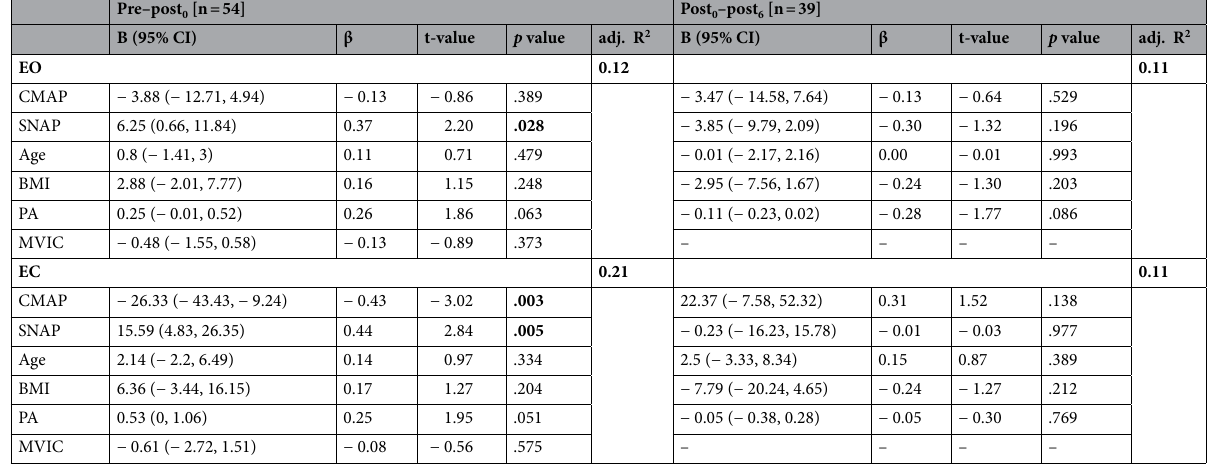
Table 3. Multiple linear regression analysis for predicting changes in postural control during and after neurotoxic chemotherapy. Results of multiple linear regression analysis investigating the influence of various predictors on changes in postural control during (pre–post 0 ) and after (post 0 –post 6 ) neurotoxic chemotherapy are shown. Bold p values are considered statistically significant ( p < .05). adj. R 2 , adjusted R 2 ; B, unstandardized regression coefficient; β, standardized regression coefficient; BMI, body mass index; CI, 95% confidence interval; CMAP, compound muscle action potential of peroneal nerve; EC, eyes closed; EO, eyes open; MVIC, maximal voluntary isometric contraction of quadriceps [∆ pre–post0 ]; PA, physical activity; post 0 , assessment point 3 weeks after neurotoxic chemotherapy; post 6 , assessment point six months after post 0 ; pre, assessment point before neurotoxic chemotherapy; SNAP, sensory nerve action potential of sural